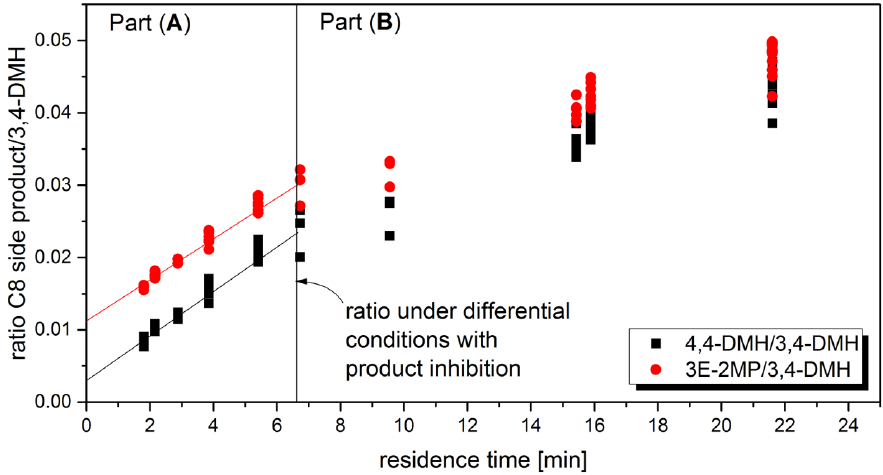
Figure 4. Ratio of the side products 4,4-DMH and 3E-2MP to the main product 3,4-dimethylhexene (3,4-DMH) at different residence times, varied through feed rate in the fixed bed reactor (100 °C, 30 bar); ( A ) linear area up to 7 min; ( B ) ratio at residence time from 7 to 25 min.